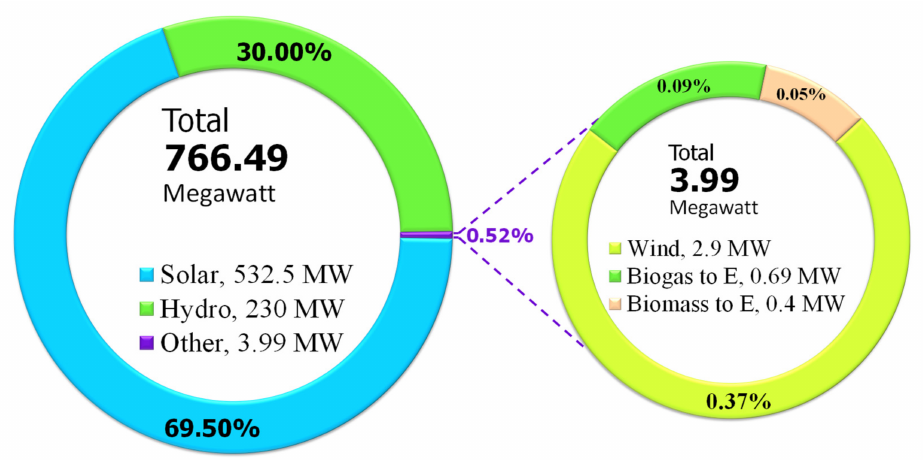
Figure 3. Current status of renewable generation capacity in Bangladesh (authors’ creation based on SREDA data